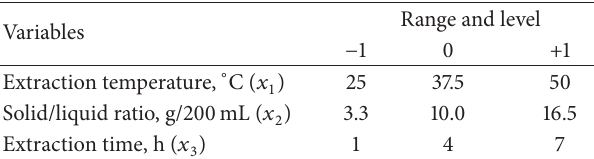
Table 1: Experimental ranges and levels of the independent vari-